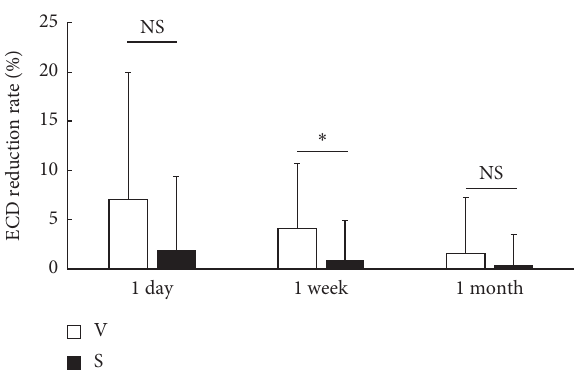
Figure 3: Comparison of the corneal endothelial cell density (ECD) reduction rate. The ECD reduction rate (mean ± standard devia- tion) is calculated from the preoperative ECD and the ECD at each time point. ECD rate is significantly higher in the V group than the S group at 1 week postoperatively ( p � 0 . 13 at 1 day, p � 0 . 03 at 1 week, and p � 0 . 43 at 1 month; Mann–Whitney U test; ∗ p < 0 . 05). NS � not significant, V � V group, and S � S